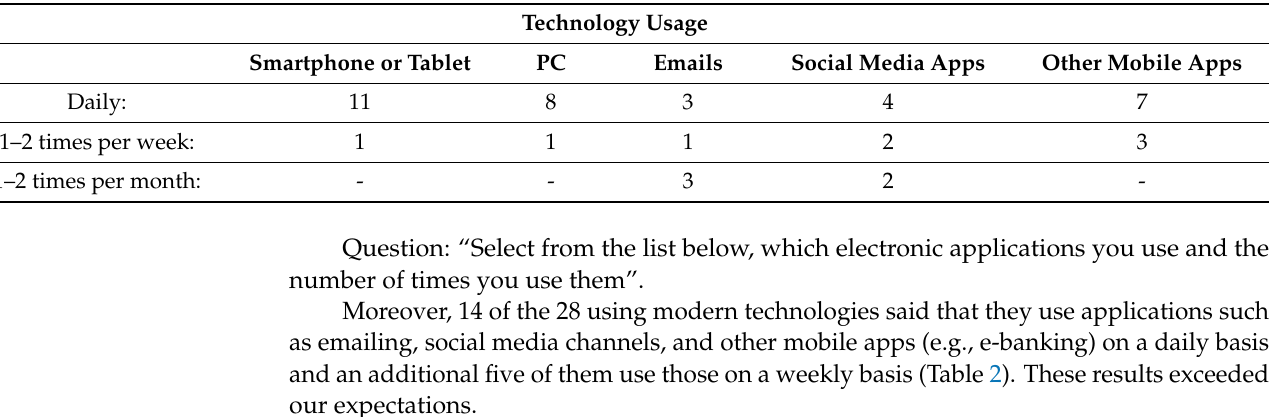
Table 2. Type of technologies and electronic applications used by elderly